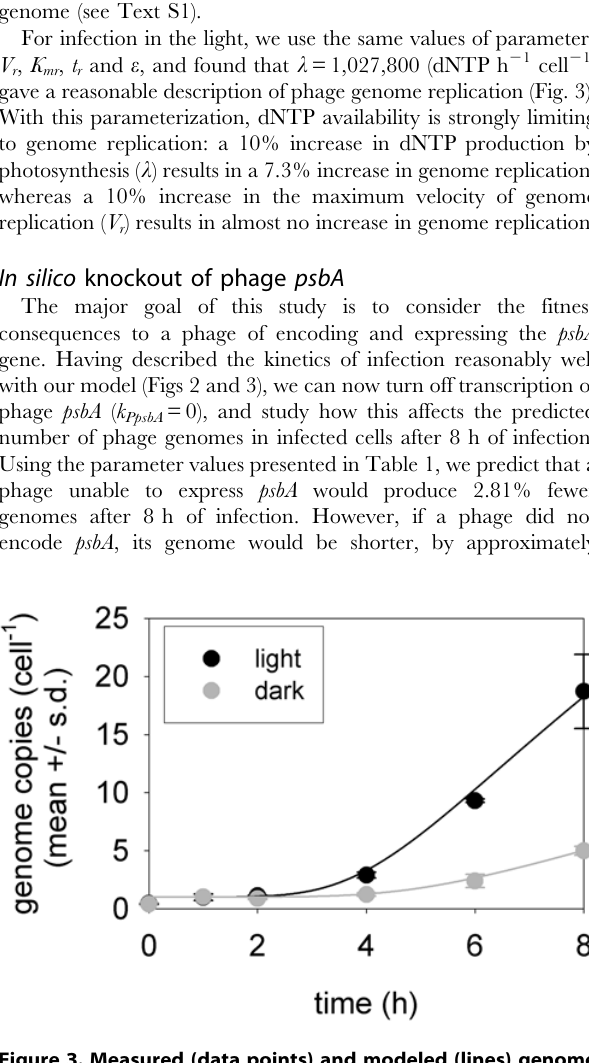
Figure 3. Measured (data points) and modeled (lines) genome copies of cyanophage P-SSP7 during the lytic cycle under light (25 m E m 2 2 s 2 1 ) and dark conditions. Genome copies were measured as genomes per ml of culture [17], and were transformed to a per cell basis for comparison to the model.